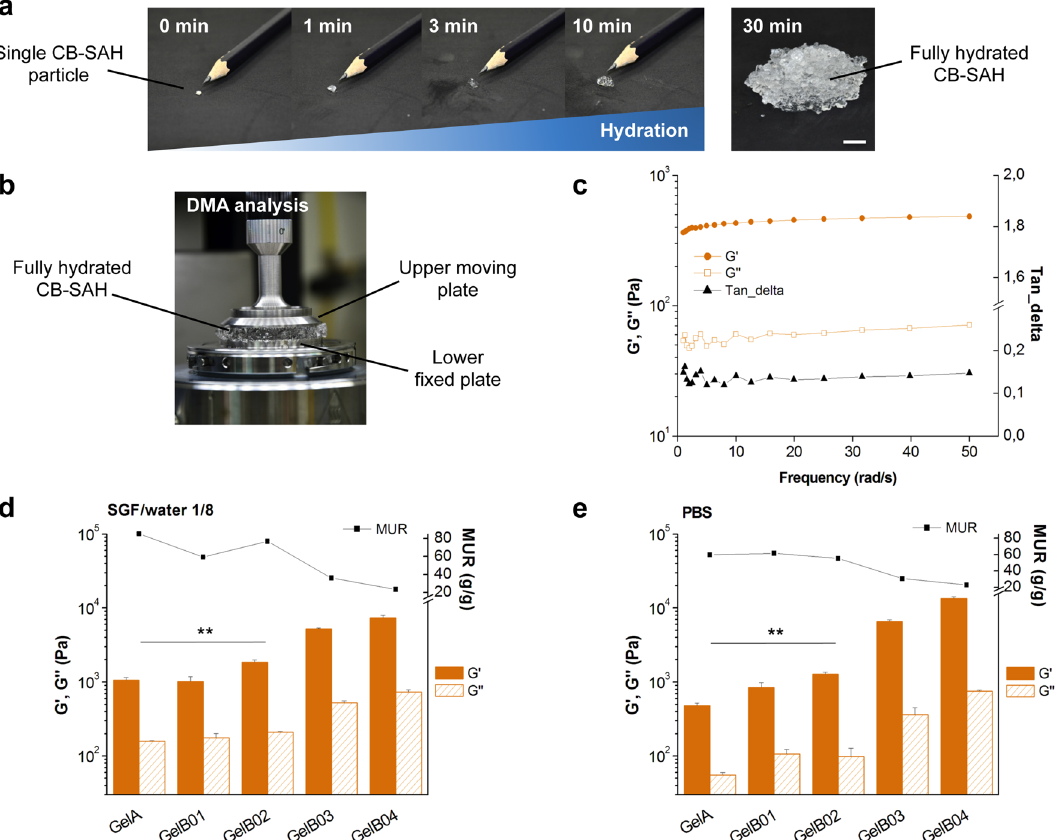
a single CB-SAH particle (GelA in SGF/water 1/8 v/v), observable as a progressive increase in size with respect to a pencil tip, and visual appearance of the fully hydrated CB-SAH (0.25 g of GelA particles, with a size range 100–1000 µm, in SGF/water 1/8 v/v; scale bar 1 cm). ( b ) Set-up of the DMA analysis to measure the elastic modulus G ′ and the viscous modulus G ″ of the hydrated CB-SAH. ( c ) Exemplary DMA curves obtained for the CB-SAHs (GelA), indicating G ′ , G ″ and the ratio G ″ /G ′ (tan_delta), as a function of frequency. ( d ) G ′ and G ″ (at 10 rad/s) and MUR of the CB-SAHs upon incubation in SGF/water 1/8 v/v. ( e ) G ′ , G ″ (at 10 rad/s) and MUR of the CB-SAHs upon incubation in PBS. In (d) and (e), results are the mean ± SD of three independent measurements. Plots in ( c ), ( d ) and ( e ) were produced with Origin 6.0, www. origi nlab. com. The different G ′ of GelA and GelB02 is highlighted by **( p <